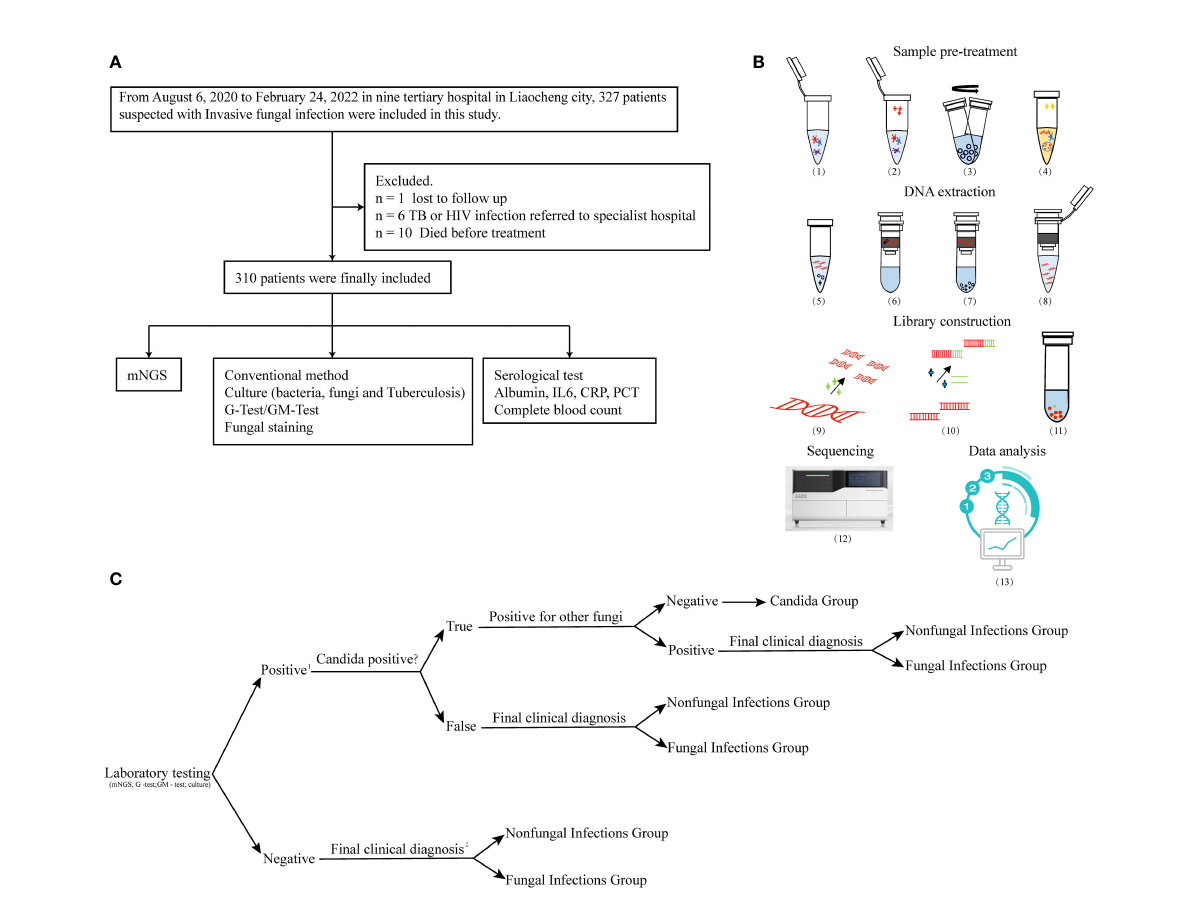
FIGURE 1 Flowchart. (A) Flowchart of participant enrollment criteria. (B) Work fl ow of mNGS. Sample pre-treatment includes the following: (1) inactivation: dry bath at 56°C for 30 min; (2) lysozyme treatment at 30°C for 10 min; (3) add micro glass grinding beads to the lysate and vortex the samples at 1,000 x g for 20 min. (4) Lysis: collect supernatants and add proteinase k and lysis solution at 70°C for 15 min. DNA extraction includes (5) application of 100% ethanol concentration to induce nucleic acid precipitation, (6) DNA binding, (7) washing, and (8) elution.